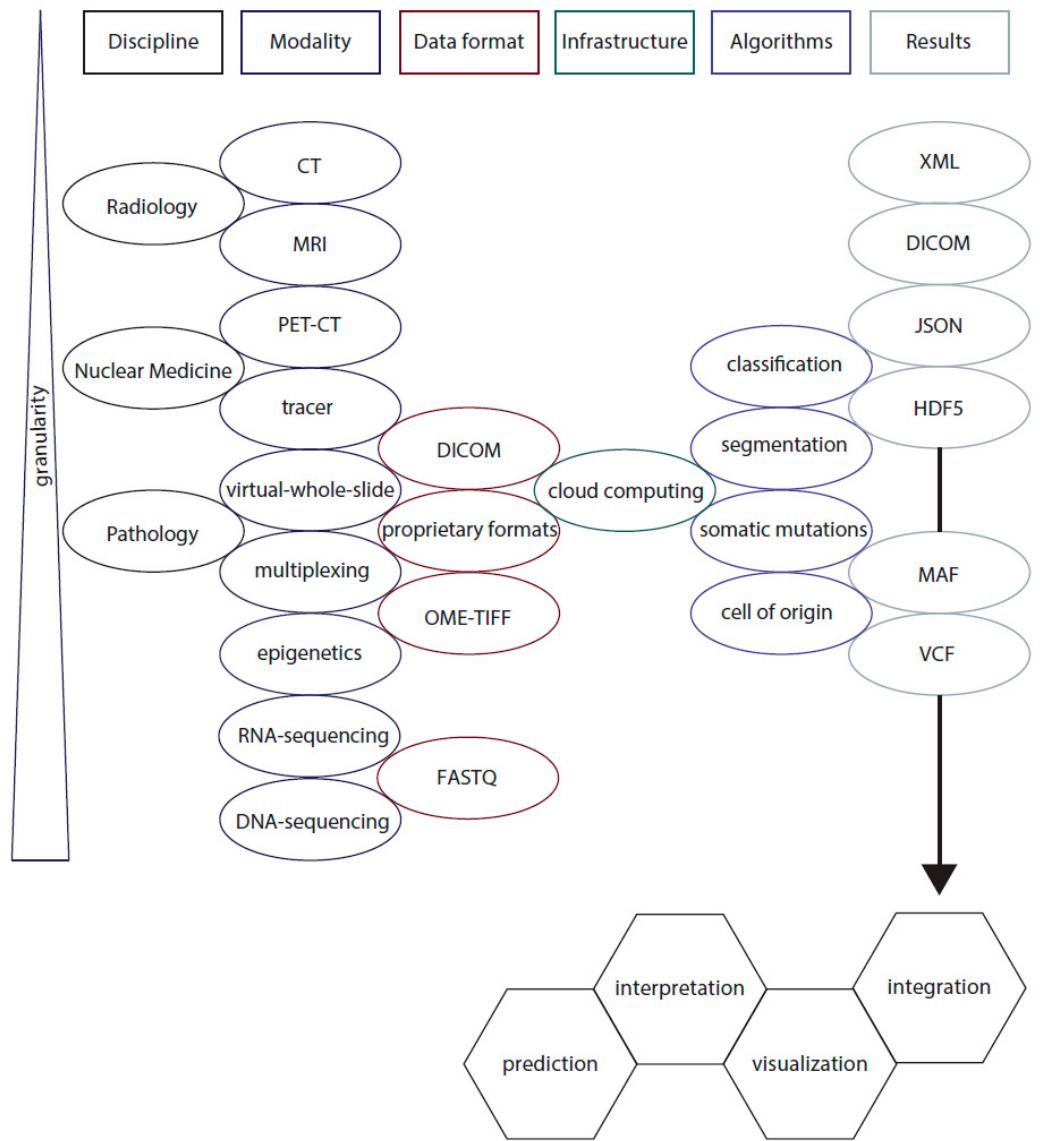
Figure 1. Schematic of integrative data analysis in oncology. Diagnostic medical disciplines, including Radiology, Nuclear Medicine and Pathology are gathering data using their different modalities, like computer tomography (CT), magnetic resonance imaging (MRI), positron emission tomography (PET-CT), as well as tracers that are able to highlight molecules of interest. While Radiology and Nuclear Medicine share a sophisticated data format of digital imaging and communications in medicine (DICOM) objects, which includes relevant (pseudonymized) patient (meta) data, other formats from virtual-whole-slide images and multiplexing techniques may be stored using proprietary vendor formats. The maturing file format of open microscopy environment tagged file format (OME-TIFF) appears to be especially interesting as future solution, as DICOM objects for virtual-microscopy-images have not yet been broadly accepted by the community [97,112,114]. Cloud computing services would require specialized structures, like central processing units (CPU) and graphical processing units (GPU) that meet the desired calculating capabilities. In the near future, several specialized algorithms will be executed allowing segmentation of regions of interest and classification of image objects, in addition to accurate variant calling and methylome-based cell of origin determination using epigenetics. The given results of image analysis are stored using extensible markup language (XML), DICOM objects or JavaScript Object Notation (JSON), to- gether with Hierarchical Data Format (HDF5). Here, spatial descriptive statistics of cellular and subcellular structures of interest are calculated. Data formats like variant calling files (VCF) and Mutation Annotation Format (MAF; https://docs.gdc.cancer.gov/Data/File_Formats/MAF_Format/, accessed on third of September 2021) may be used to store results of DNA-sequencing. Finally, the data need to be integrated and visualized [115,116] to allow interpretation in order to allow patient stratification, identifying risk groups of cancer patients and to predict therapy responses. Given the increasing complexity within oncology, analytical tools are needed to retrieve current information on drug targets, clinical trials and potential treatment options, which may need to be integrated in a given workflow [117,118] .